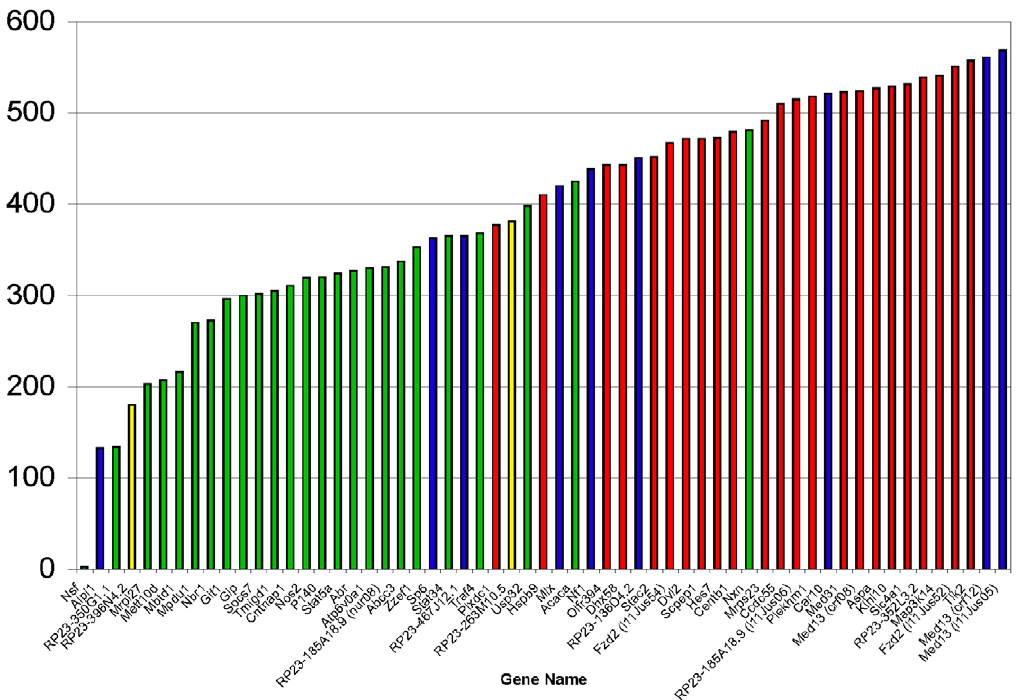
Figure 2. Conservation analysis of sequence surrounding ENU–induced lesions. A graph of match scores shows that exons and some non- coding elements are highly conserved. The match score is based on a 100 base pair comparison across seven vertebrates: mouse, human, rat, Rhesus monkey, horse, dog, and chicken. Red=lesion occurred in an exon, blue=lesion occurred in a 5 9 or 3 9 UTR, green=lesion occurred in an intron, and yellow=lesion occurred downstream of a gene.